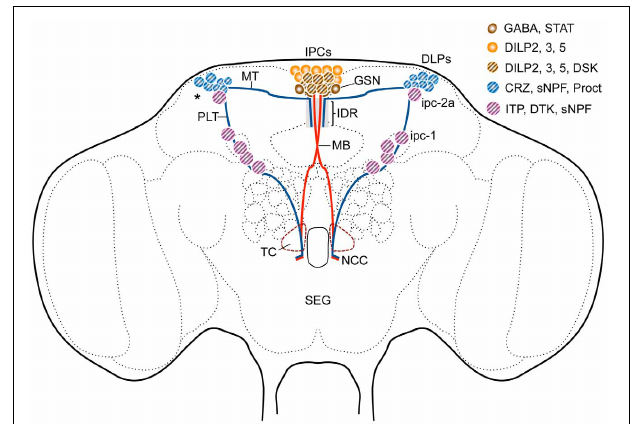
FIGURE 3 | Sets of peptidergic neurons in the Drosophila brain that are associated with the IPCs. Some of the IPCs co-express drosulfakinins (DSK1 and 2), peptides that induce satiety (Söderberg et al., 2012). The IPCs are regulated by DLP neurons that produce short neuropeptide F (sNPF), corazonin (CRZ) and proctolin (Proct) (Isaac et al., 2004; Kapan et al., 2012) as well as GABAergic neurons (GSN) that in turn receive leptin-like (Upd2) signals from the fat body (Rajan and Perrimon, 2012). The GSNs express a Upd2-activated Jak/Stat receptor (Dome). The interactions between DLPs and GSNs and IPCs probably occur dorso-medially (IDR) in the pars intercerebralis and maybe in the tritocerebrum (TC). Another set of lateral neurosecretory cells (LNCs), designated ipc-1 and ipc-2a, express the peptides sNPF, Drosophila tachykinin (DTK) and ion transport peptide (ITP) (Kahsai et al., 2010). These neurons, like the DLPs, are parts of the LNC clusters and have axon terminations in sites overlapping those of the IPCs and the DLPs in the corpora cardiaca and anterior aorta. Further abbreviations: STAT, Jak/stat receptor Dome; MT, medially projecting axon tract; PLT, posterior lateral axon tract; MB, median bundle; NCC, nerves to corpora cardiaca. Asterisk indicates region where dendrites of DLPs